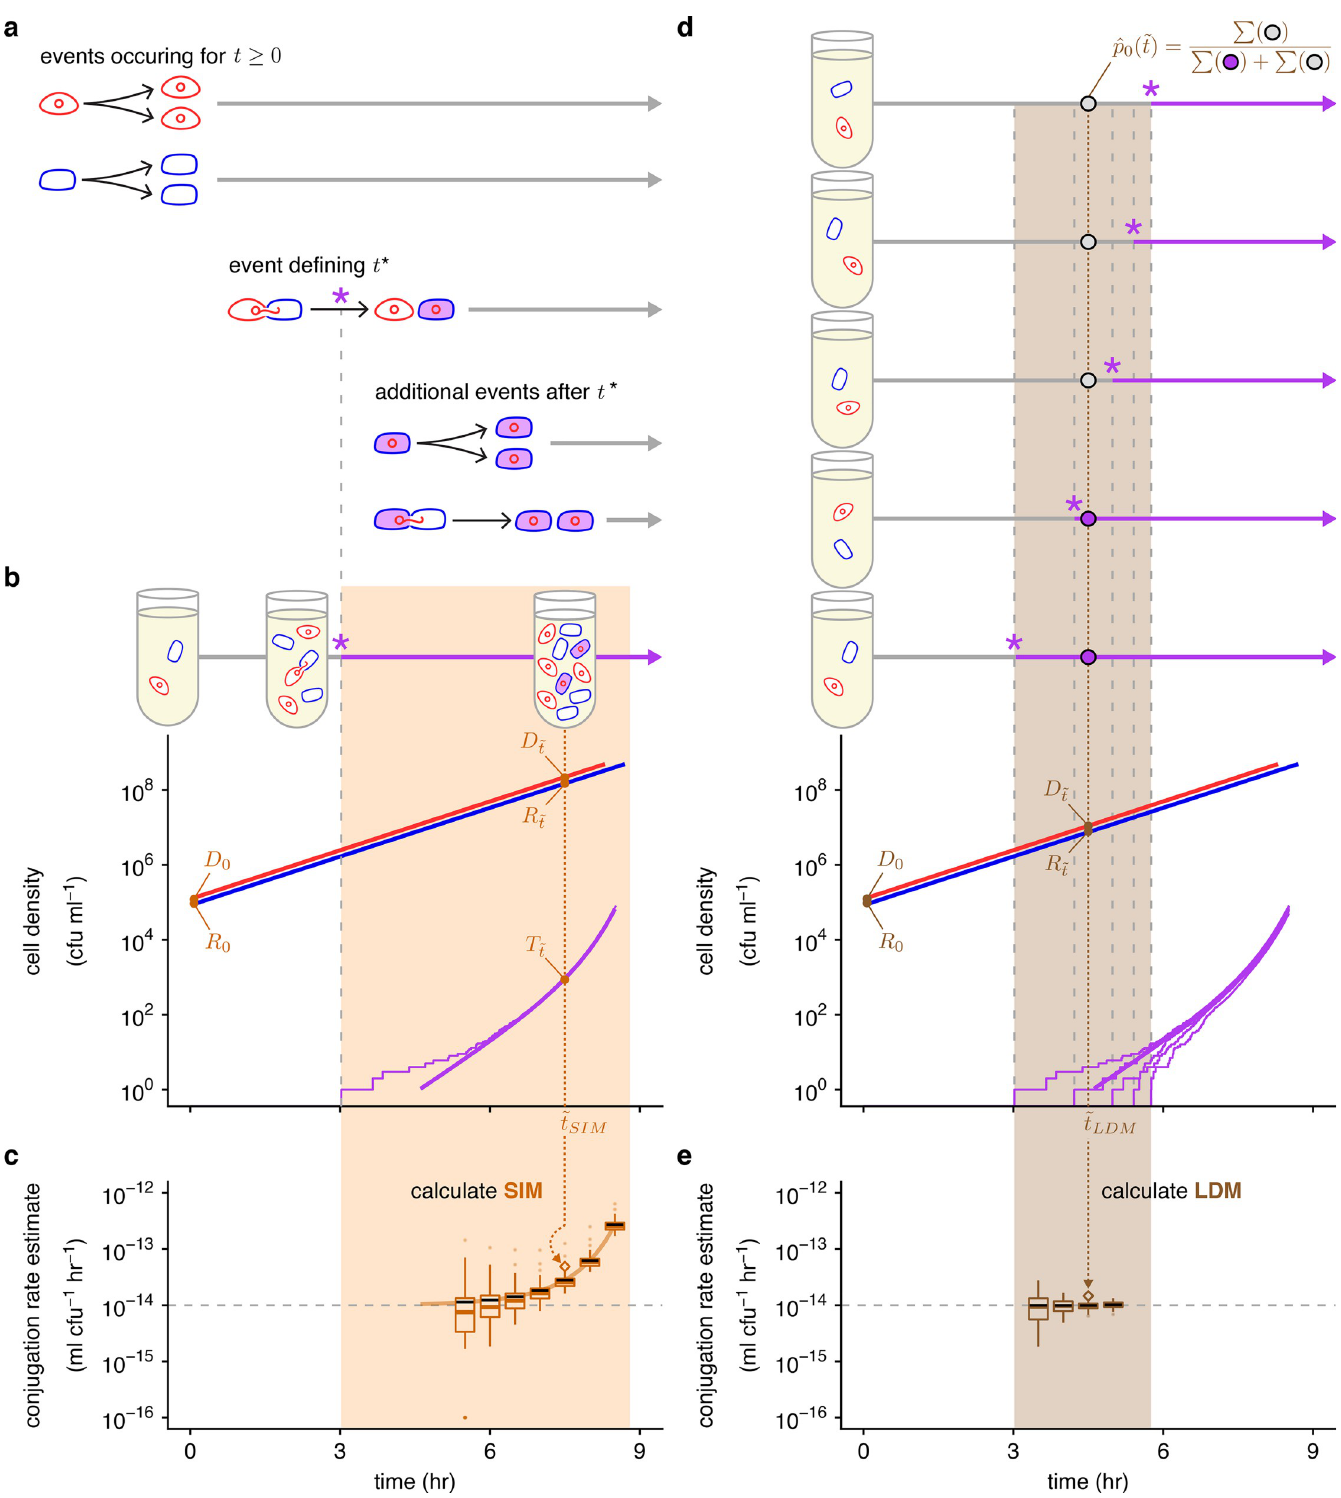
Fig 3. Overview of stochastic simulation framework and the effects of incubation time on estimating conjugation rate. (a) The mating assay starts ( t = 0) with donors and recipients and their populations increase over time. At a critical time ( t � , marked by a purple asterisk), the first transconjugant cell is generated through a conjugation event between a donor and recipient. After t � , all possible growth and conjugation events can occur (including transconjugant division and conjugation). (b) A stochastic simulation of Eqs 1–3 shows the donor, recipient, and transconjugant densities (red, blue, and purple thin trajectories, respectively) increasing over